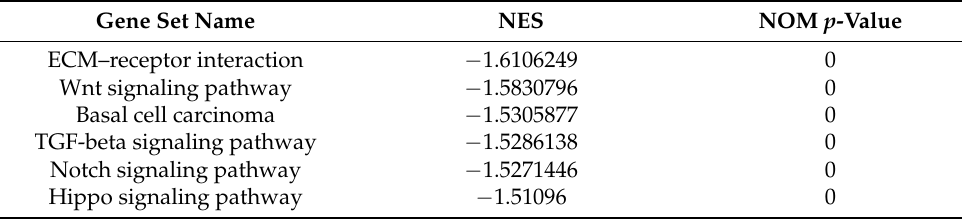
Figure 4. The enriched KEGG pathways of DEGs in hair follicles between coarse and fine wool. p value < 0.05 was considered to indicate a significant difference. Table 2. Gene sets enriched in the hair follicle of fine wool